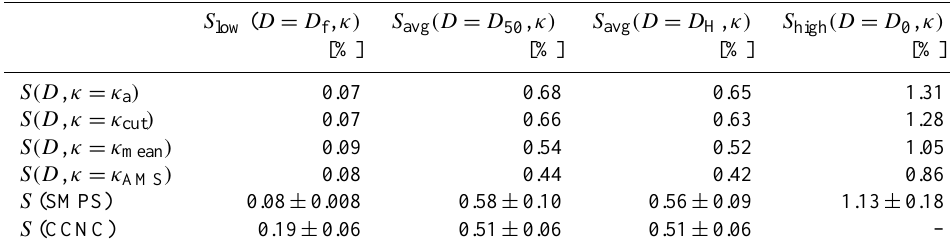
Table 2. Lower bounds, average values, and upper bounds of cloud peak supersaturation ( S low , S avg , S high ) obtained by Köhler theory calculations assuming different types of hygroscopicity parameter ( κ a ,κ cut ,κ mean , κ AMS ) as reported in Table 1 (SMPS method, Sect. 3.2). The values displayed in the second-last line represent the arithmetic mean ± standard deviation of the preceding four lines (SMPS method average). The supersaturation values displayed in the last line were obtained without assumptions about particle hygroscopicity (arithmetic mean ± standard deviation; CCNC method, Sect.